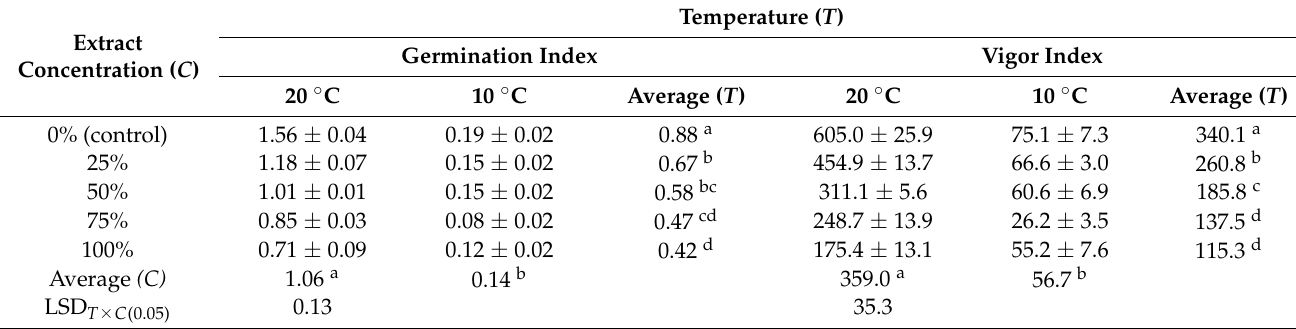
Table 8. Germination index (GI) and vigor index (VI) at two temperatures (20 and 10 ◦ C), in wheat cv. Mongibello in relation to the hemp leaf extract concentrations. For the main effects ( T = temperature, C = concentration), means followed by the same letter are not significantly different at p < 0.05 (Tukey’s test). LSD interaction value is also reported.